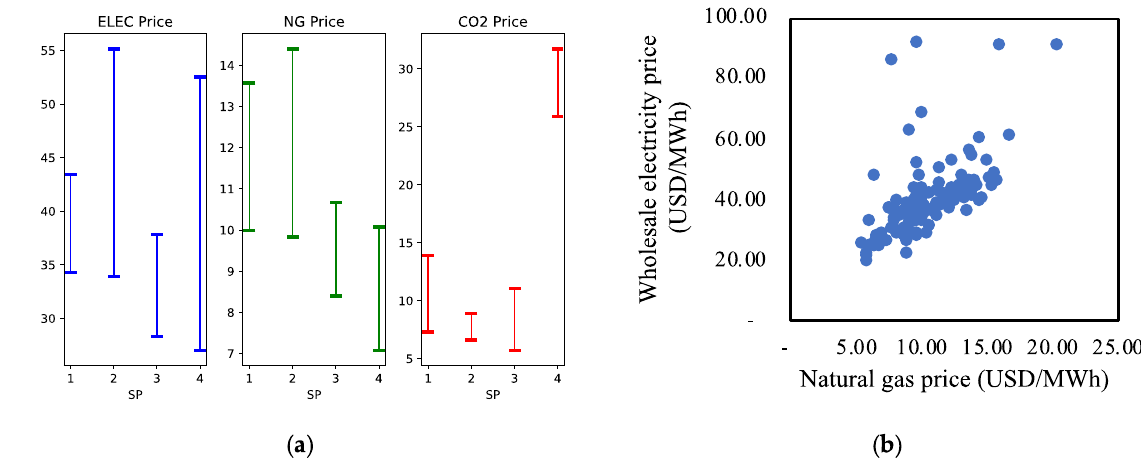
Figure 2. ( a ) 95% confidence intervals for the population mean of all sub-periods; ( b ) Scatter plot of natural gas and wholesale electricity prices.